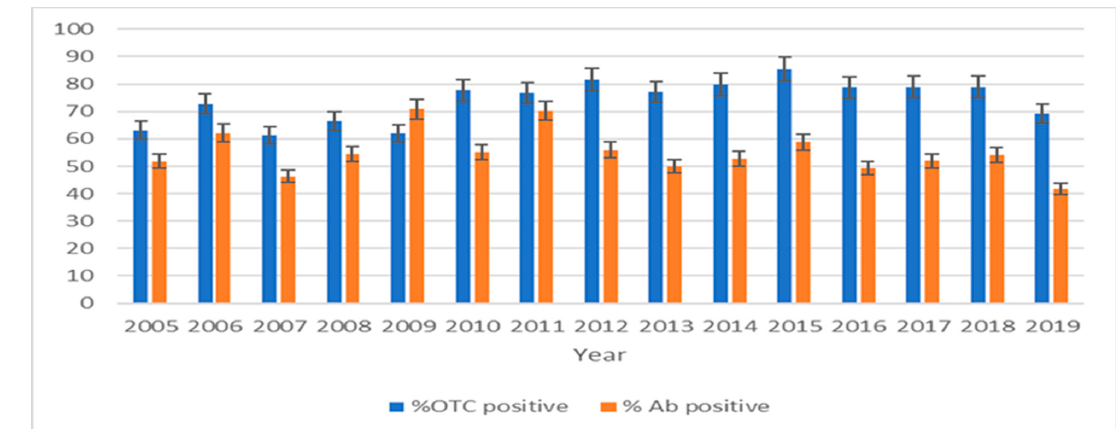
Figure 4. The percentage of oxytetracycline-positive (% OTC positive) and the percentage of rabies antibody-positive foxes (% Ab positive) between 2005 and 2019 in Slovenia with presented 95% confidence limits.